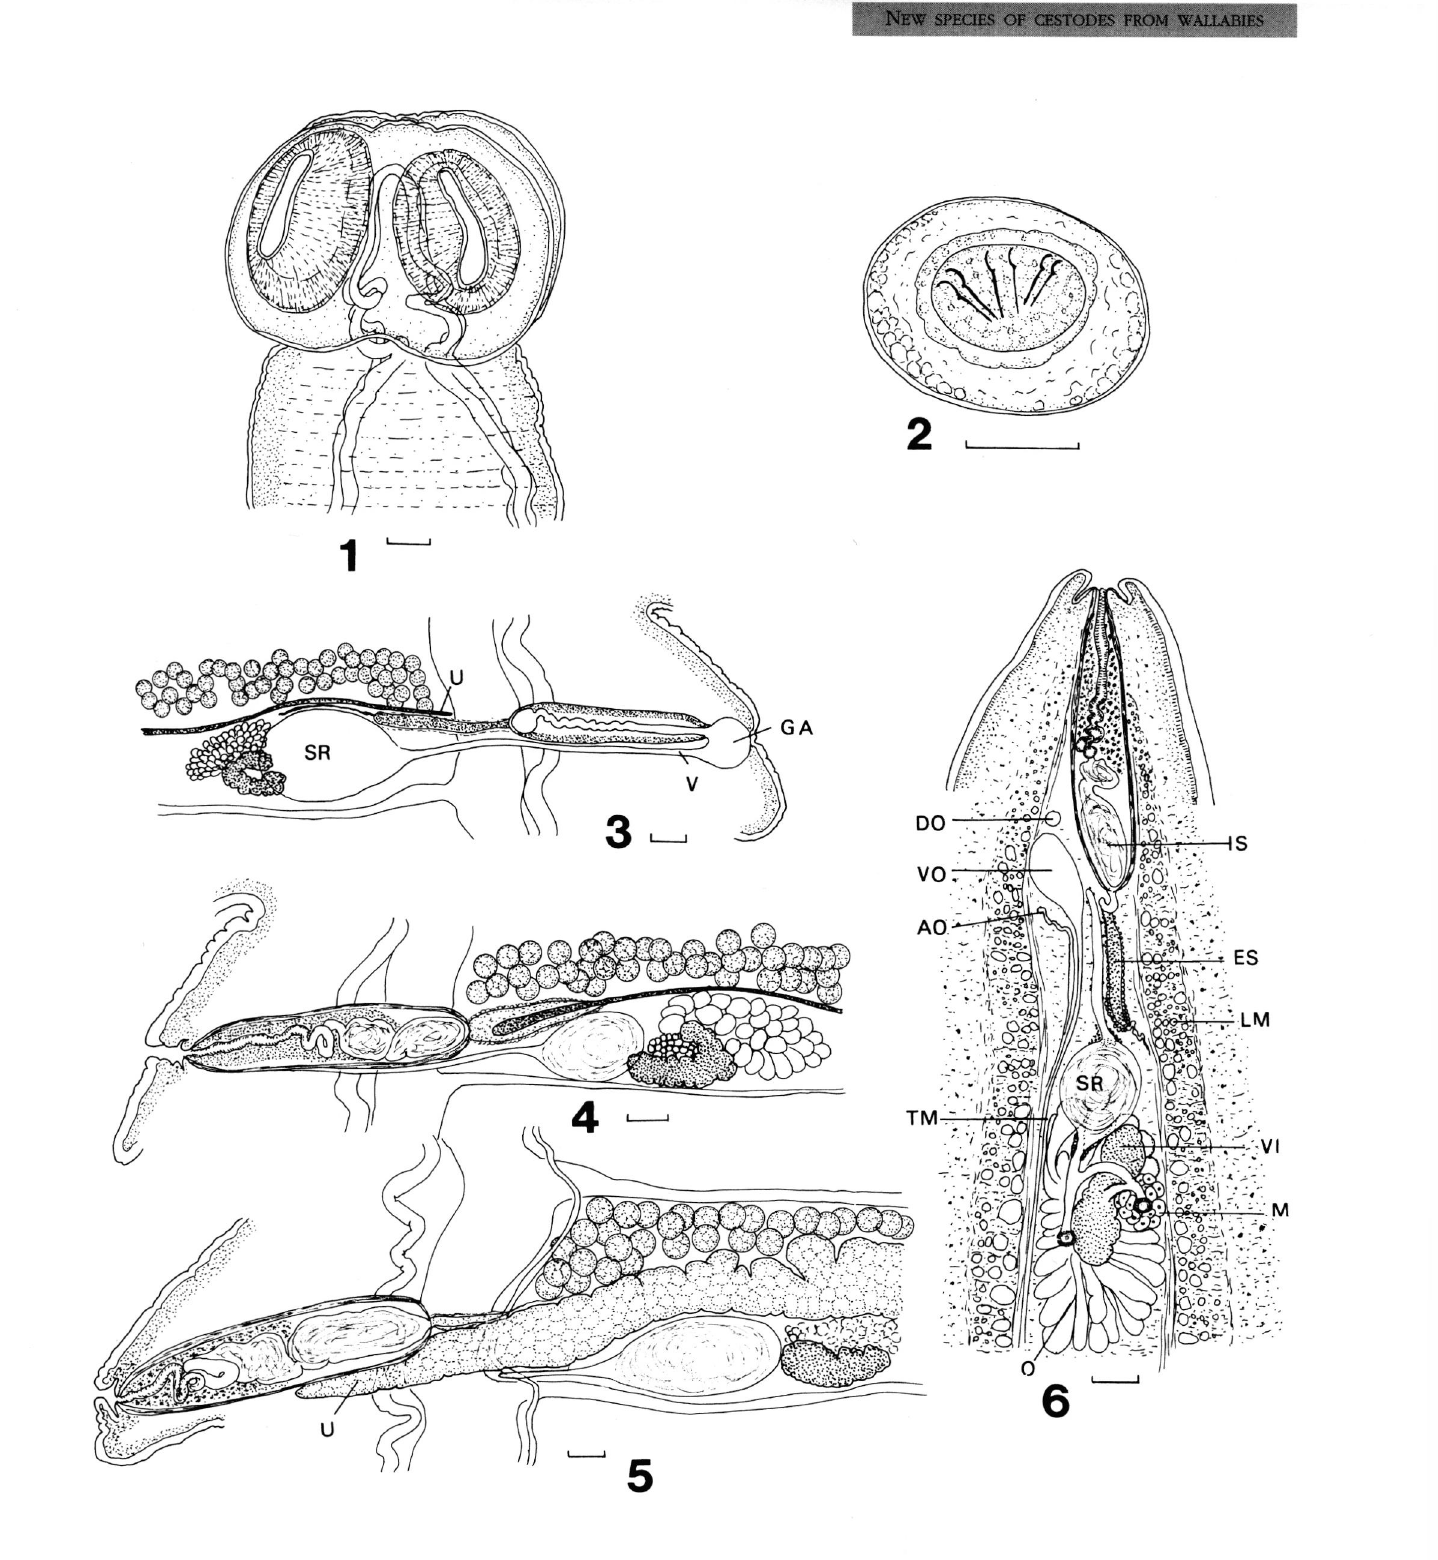
Figs 1-6. - Progamotaenia capricorniensis sp. nov. from Macropus dorsalis (Marsupialia). Fig. 1. Scolex, dorsoventral view. Fig. 2. Egg. Fig. 3. Lateral margin of premature proglottis showing circular genital atrium not opening to exterior and vagina extending from seminal receptacle to genital atrium. Fig. 4. Lateral margin of mature proglottis showing patent genital atrium and cirrus sac with sperm in internal seminal vesicle. Fig. 5. Lateral margin of postmature proglottis showing uterus starting to extend across osmoregulatory canals towards posterolateral margin of proglottis and vagina reduced to blind tube extending laterally from seminal receptacle but scarcely reaching osmo regulatory canals. Fig. 6. Transverse histological section of proglottis showing musculature and genital ducts passing osmoregulatory canals dorsally. Scale-lines: Figs 1, 3-6, 0.1 mm; Fig. 2, 0.01 mm. Abbreviations: AO, accessory osmoregulatory canal; DO, dorsal osmoregulatory canal; ES, external seminal vesicle; GA, genital atrium; IS, internal seminal vesicle; LM, inner longitudinal muscles; M, Mehlis' gland; O, ovary; SR, seminal receptacle; TM, transverse muscle; U , uterus; V, vagina; VI, vitellarium; VO, ventral osmoregulatory